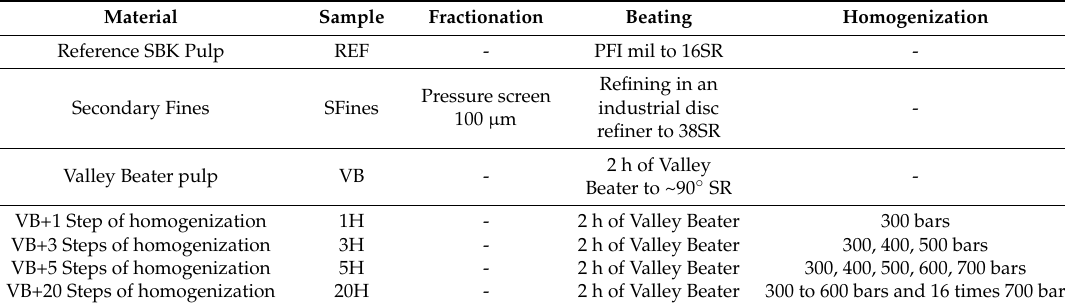
Table 1. Detail of the materials used in the study with corresponding